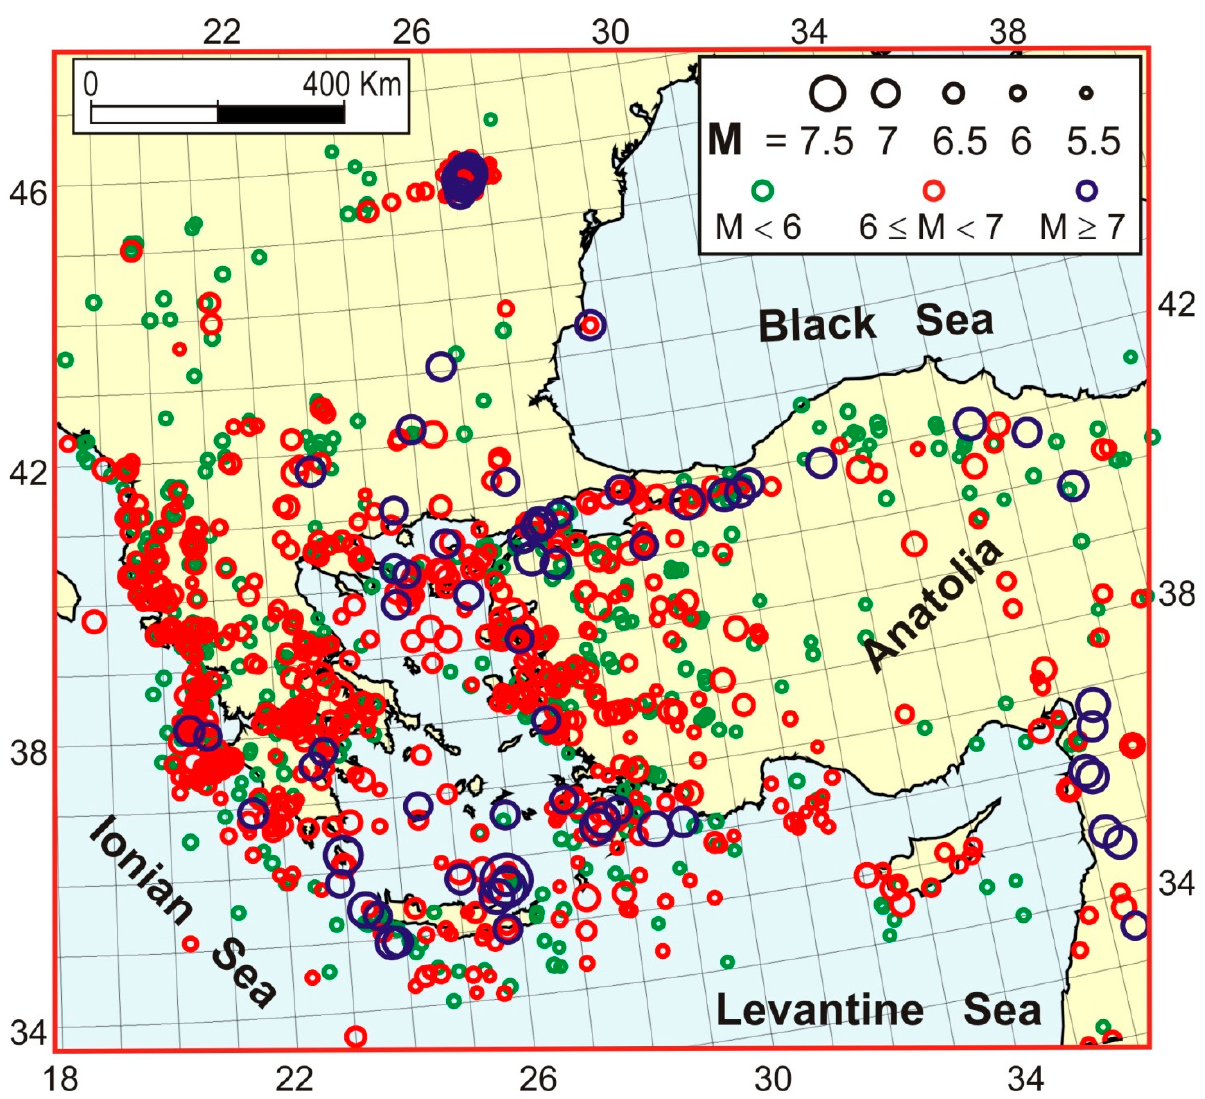
Figure 1. Distribution of major earthquakes M ≥ 5.5) in the study area (since 1000 A.D.). Data from [3–16].